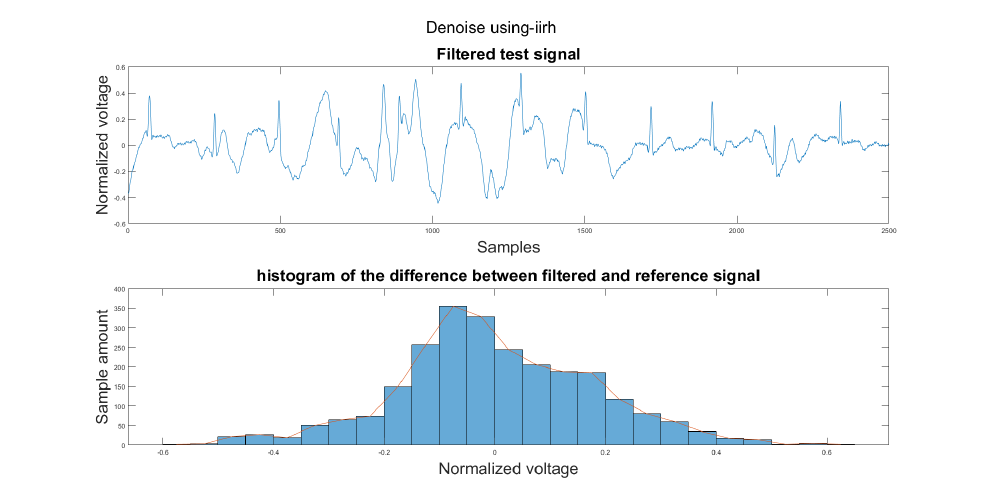
Figure A8. (1) Test signal, (2) histogram of the